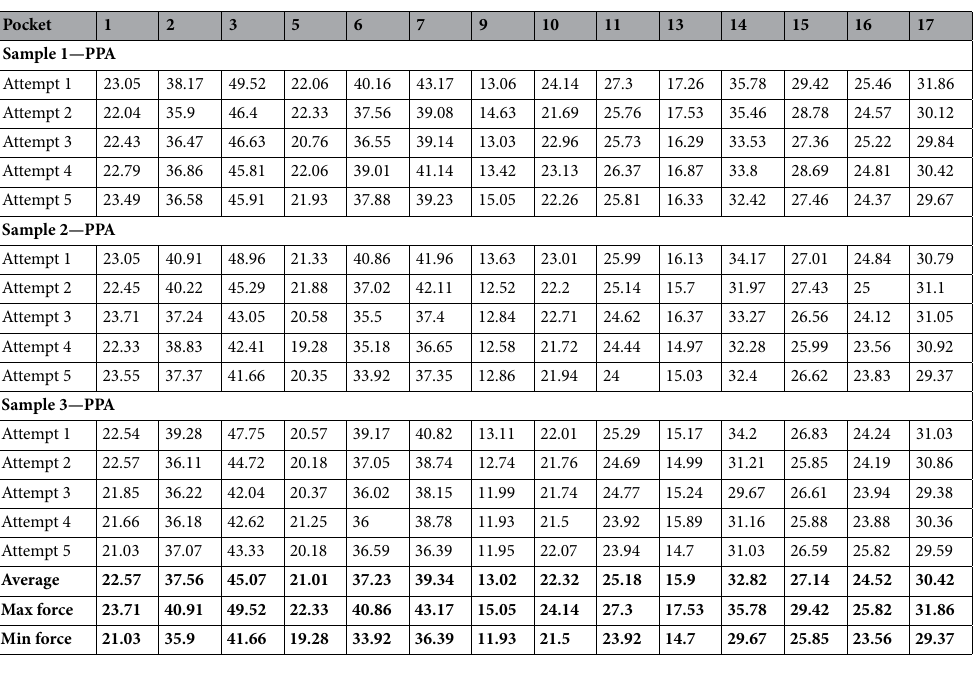
Table 5. Measured forces of PPA cages. The [Bold] values are used in the subsequent calculations and plots.